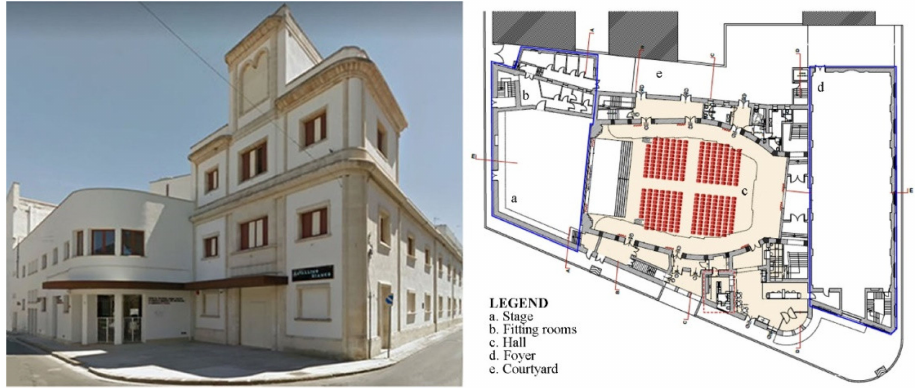
Figure 1. External view and ground-floorplan of the “Cavallino Bianco”